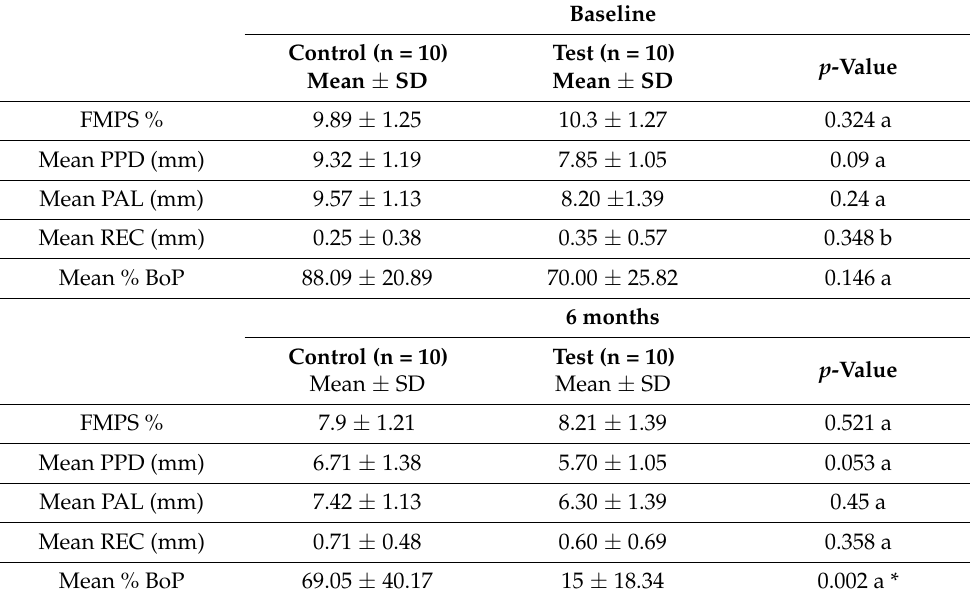
Table 2. Baseline and 6-month clinical values.